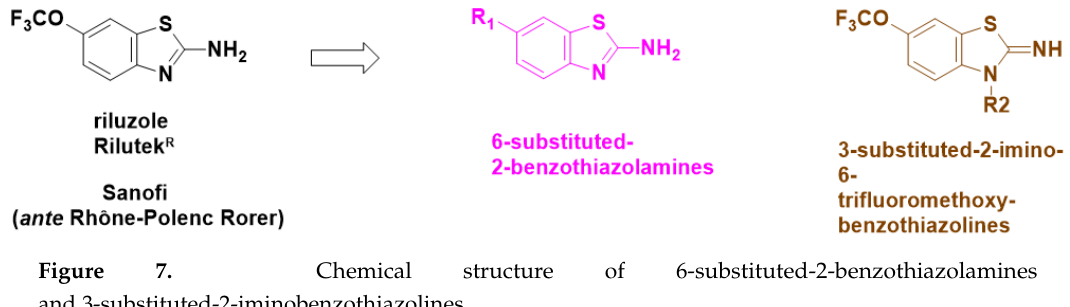
Figure 7. Chemical structure of 6-substituted-2-benzothiazolamines and 3-substituted-2-iminobenzothiazolines.